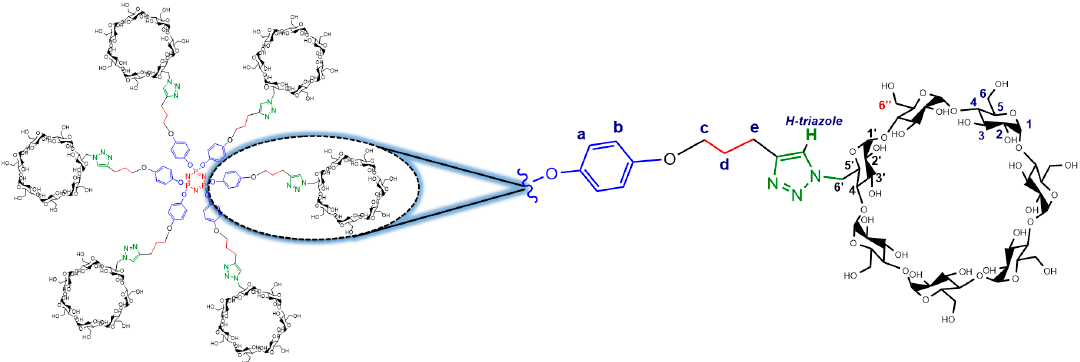
Figure 1. Assignation of the protons in the NMR of P 3 N 3 -[ O -C 6 H 4 - O -(CH 2 ) 3 - β CD] 6 dendritic compounds (PDCs).